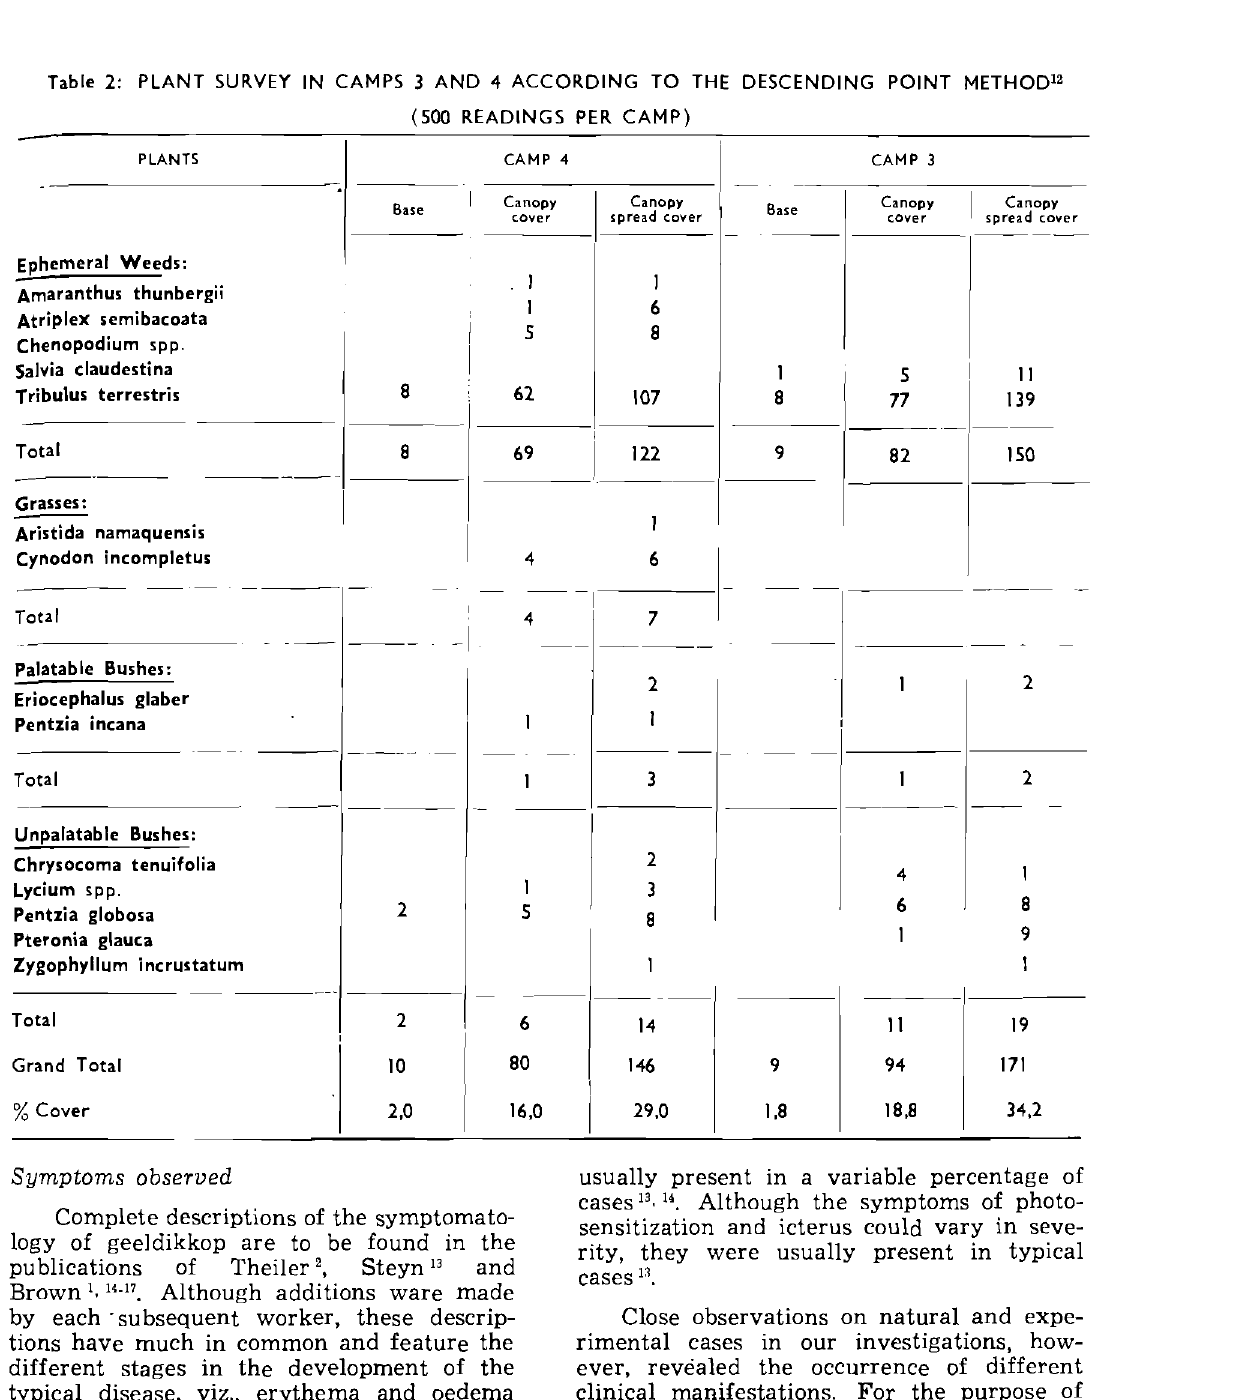
Table 2: PLANT SURVEY IN CAMPS 3 AND 4 ACCORDING TO THE DESCENDING POINT METHOD12 (500 READINGS PER CAMP) - PLANTS CAMP 4 CAMP 3 I Canopy Canopy Base Canopy Canopy Base cover spread cover cover spread cover I